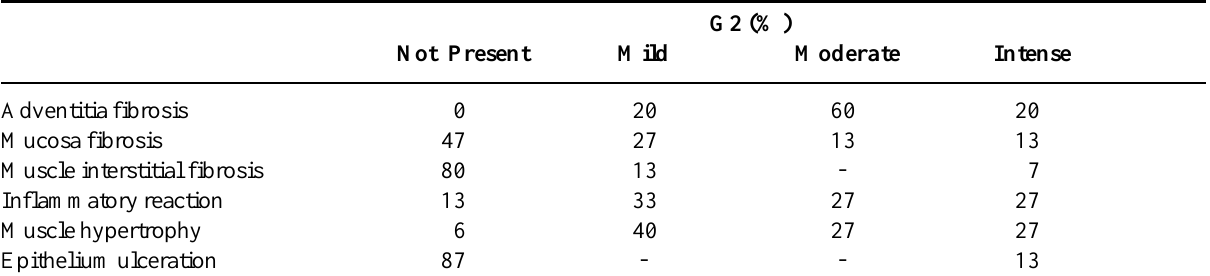
Table 2 – Percentage of adventitial, mucosal and muscle interstitial fibrosis, inflammatory reaction, muscle hypertrophy and epithelium ulceration observed in the group with partial bladder outlet obstruction (G2) 4 weeks after surgery.